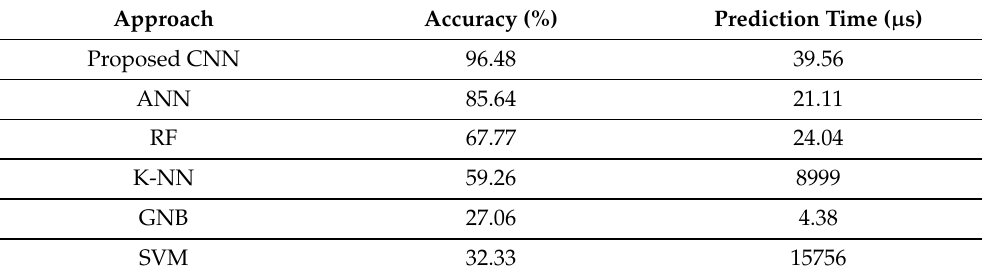
Table 6. Classification accuracy and average prediction time comparison for CSI approach.